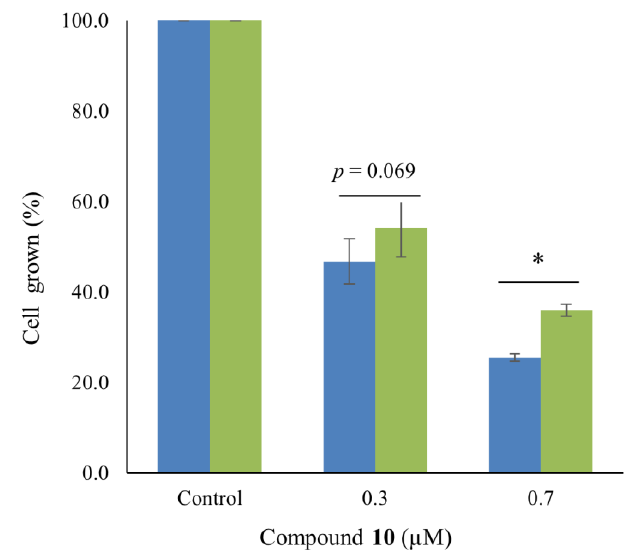
Figure 4. Cellular viability of OVCAR-8 cells treated with compound 10 in the absence (blue) and presence (green) of 30 µM MnTBAP. Cellular viability was assessed by the MTT assay. Data are presented as mean ± SE of at least three independent experiments. Differences in the cell viability values of cells with and without MnTBAP treatment were considered significant at * p < 0.05.